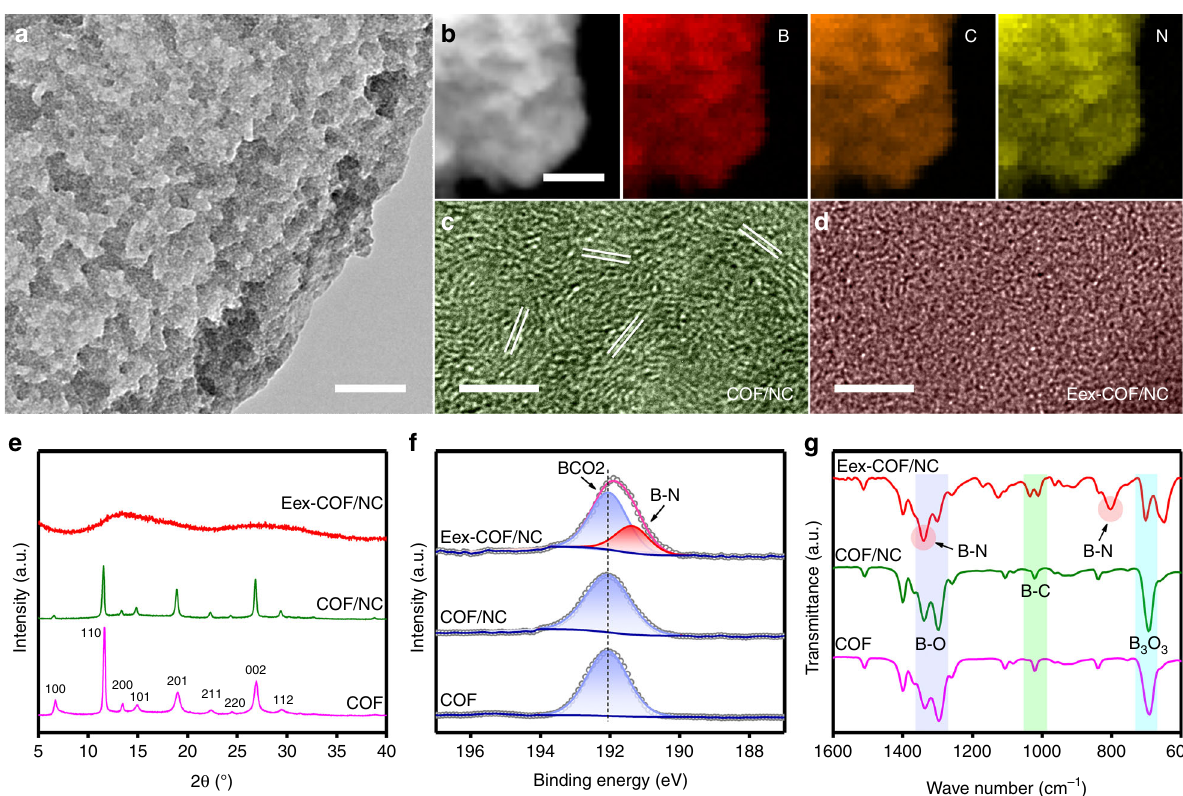
Fig. 2 Physical characterization. a Transmission electron microscopy (TEM) image and b element mappings of Eex-COF/NC. High-resolution TEM images of c COF/NC and d Eex-COF/NC. Scale bars, a 200 nm; b 100 nm; c 5 nm and d 5 nm. e X-ray powder diffraction (XRD) patterns, f high-resolution B 1s spectra, and g Fourier-transform infrared (FTIR) spectra of different